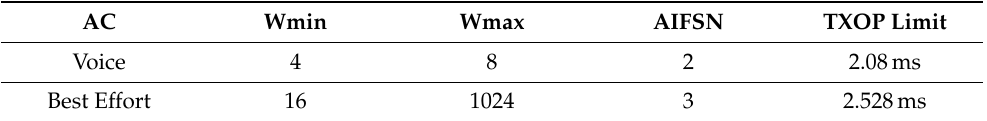
Table 1. Default EDCA parameters for client